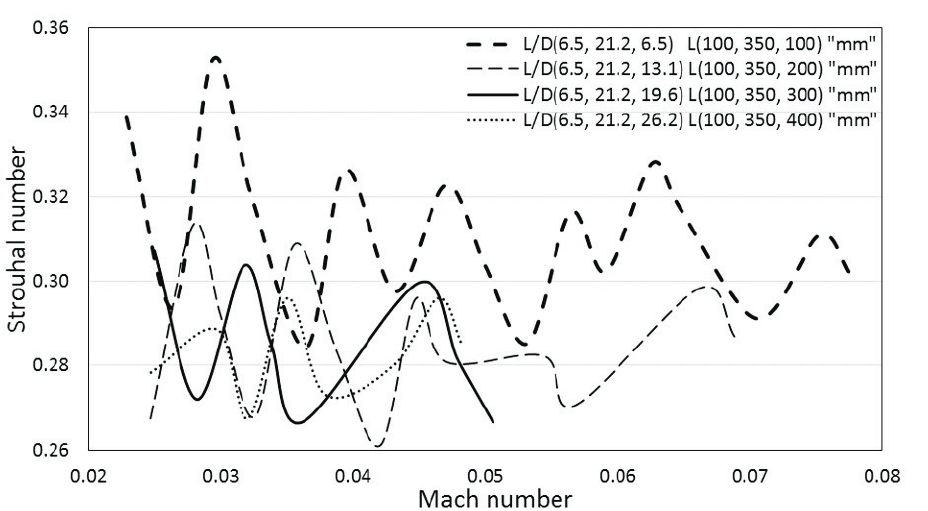
Figure 9. Strouhal number St plotted against Mach number M for L up = 100 mm, L corr = 350 mm, and L dw = 100–400 mm. Table 5. Mach number range, corresponding Strouhal number ( St ) range and maximum Strouhal number for each pipe configuration in Case a-II.